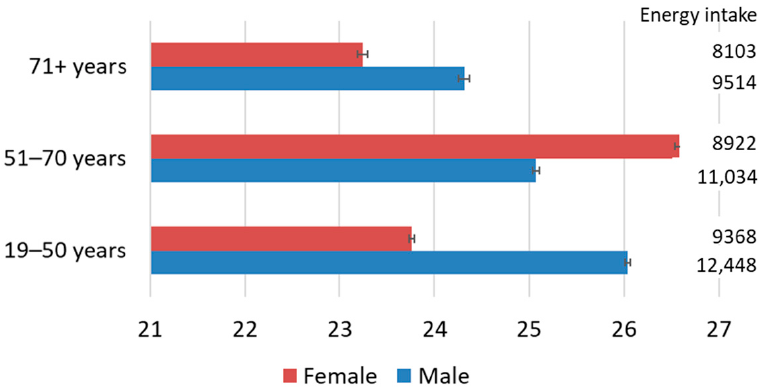
Figure 1. The pesticide toxicity footprint (points) and energy intake (kJ day − 1 ) of Australian adult diets based on 9341 individual daily diets reported in the Australian Health Survey. Bars show 95% confidence